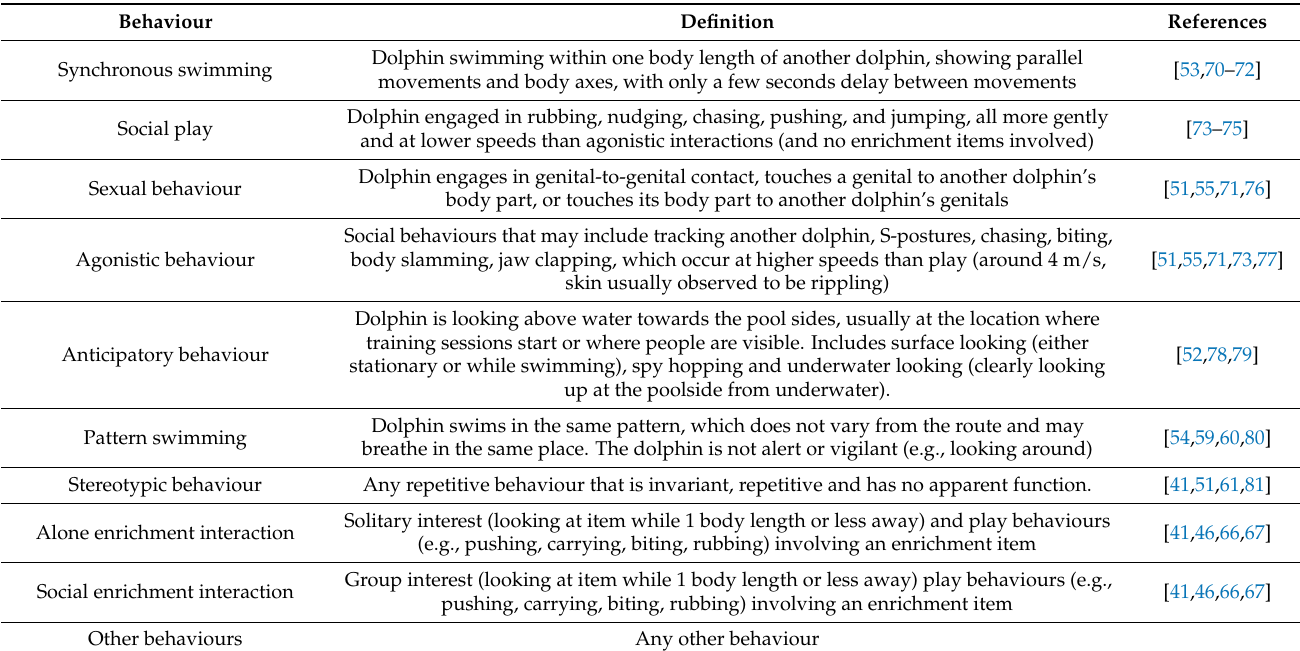
Table 2. Welfare-related bottlenose dolphin behaviours (with definitions and references showing link to welfare) included in the study’s ethogram for the behavioural observation